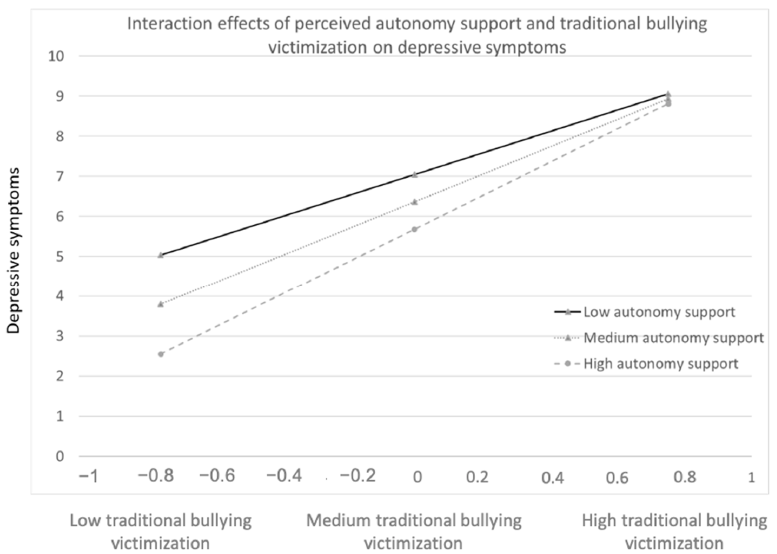
Figure A1. Interactions between autonomy support, traditional bullying victimization, and depressive symptoms.